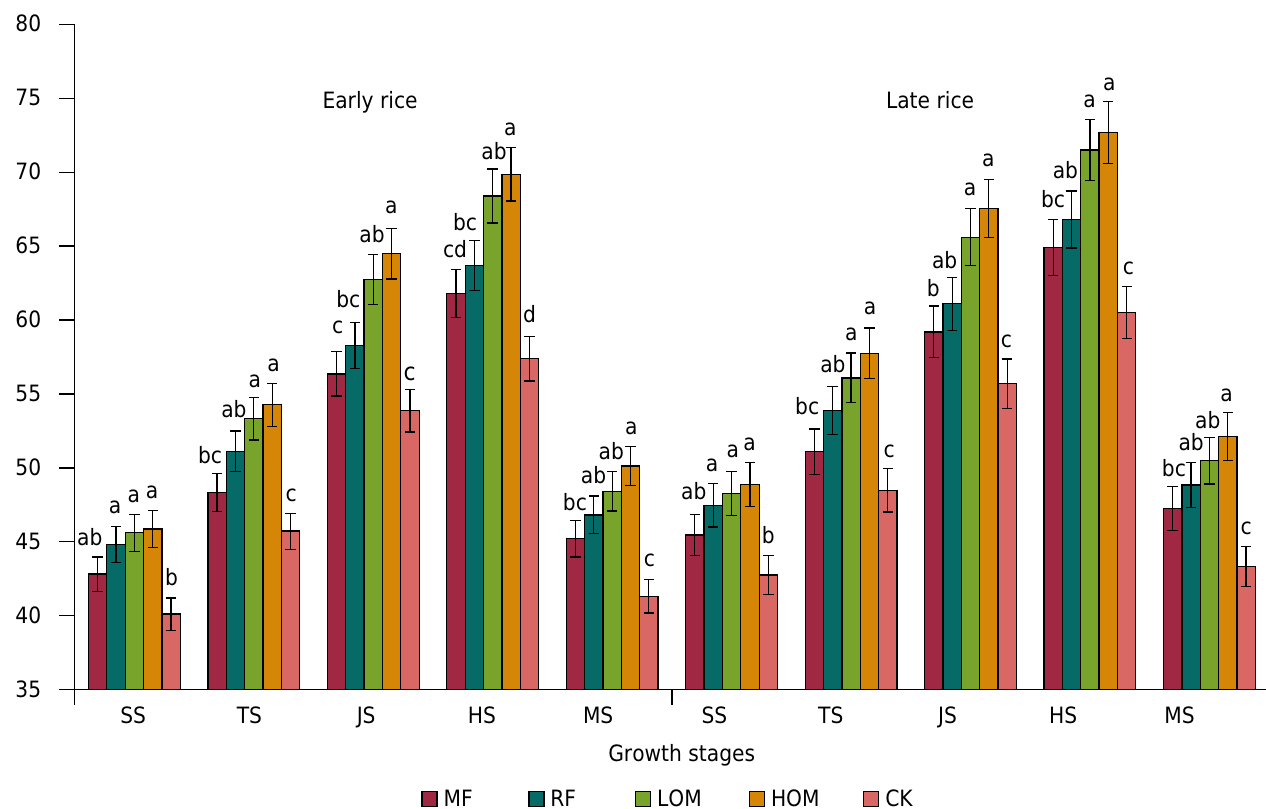
Figure 3. Effects of different long-term fertilization treatments on soil microbial biomass nitrogen in a paddy field at main rice growth stages. MF = mineral fertilizer alone; RF = rice straw residues and mineral fertilizer; LOM = 30 % organic matter and 70 % mineral fertilizer; HOM = 60 % organic matter and 40 % mineral fertilizer; CK = without fertilizer input; SS = seedling stage; TS = tillering stage; JS = jointing stage; HS = heading stage; MS = mature stage. Bars represent standard deviation (SD) of three replicates. Different letters indicate significance at p < 0.05 among the fertilization treatments at the same rice growth stage, according to the least significant difference